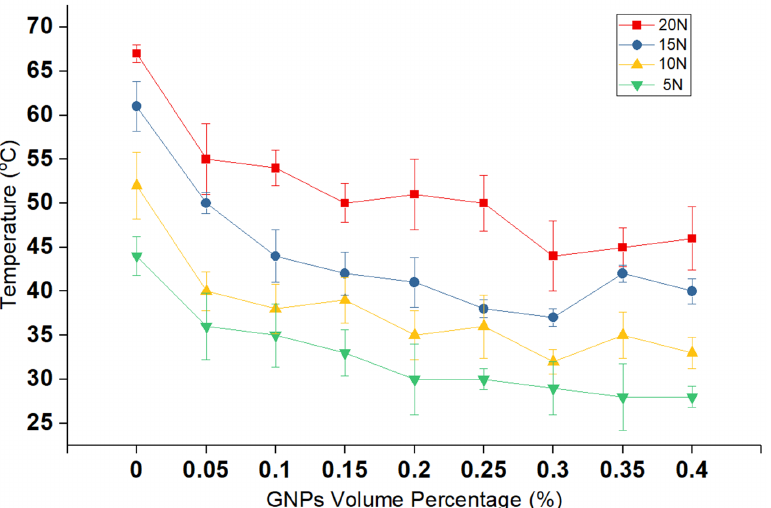
Figure 3. The variation of surface temperature at different volume percentages of GNPs at several loads.